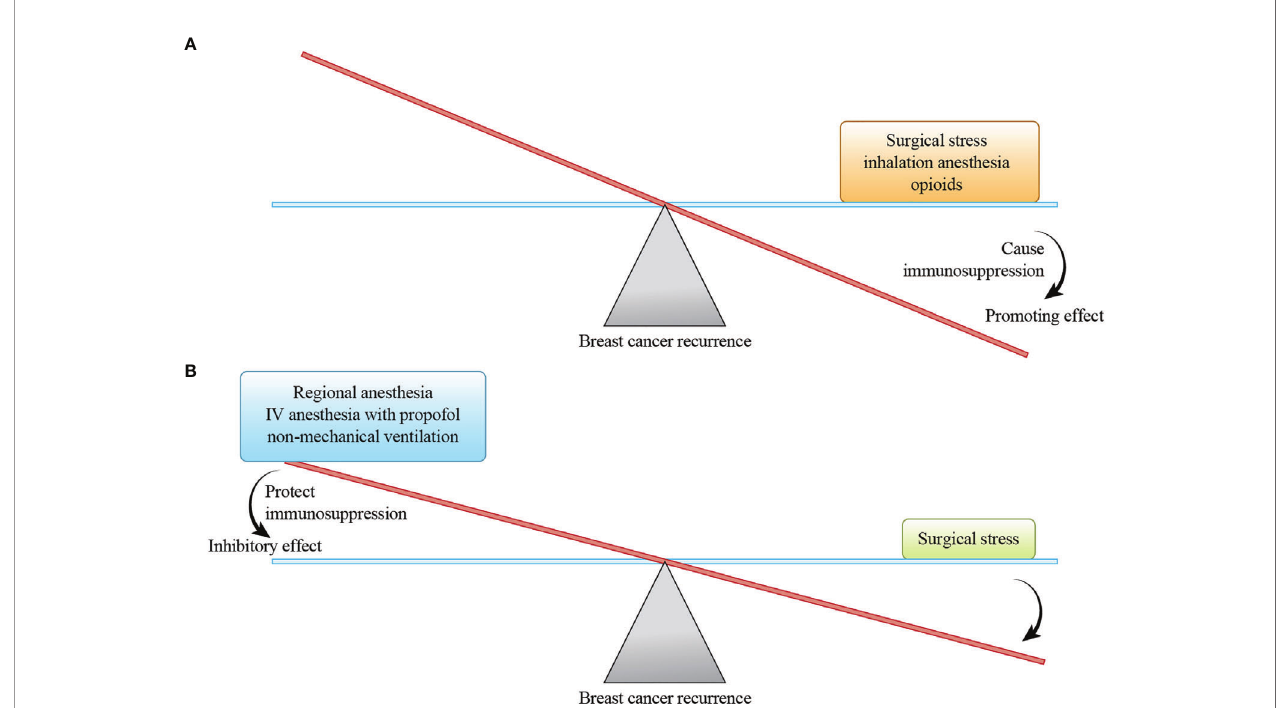
FIGURE 2 | A hypothetical balance of recurrence-promoting and -inhibiting factors related to breast cancer surgery. The magnitude of the promoting effect depends on the size of the breast cancer surgery, and the magnitude of the inhibitory effect depends on the inhibiting factors selected. (A) Surgical stress, inhalation anesthesia, and opioids promote breast cancer recurrence by causing immunosuppression. (B) Regional anesthesia, intravenous (IV) anesthesia with propofol, and non-mechanical ventilation reduce breast cancer recurrence by protecting